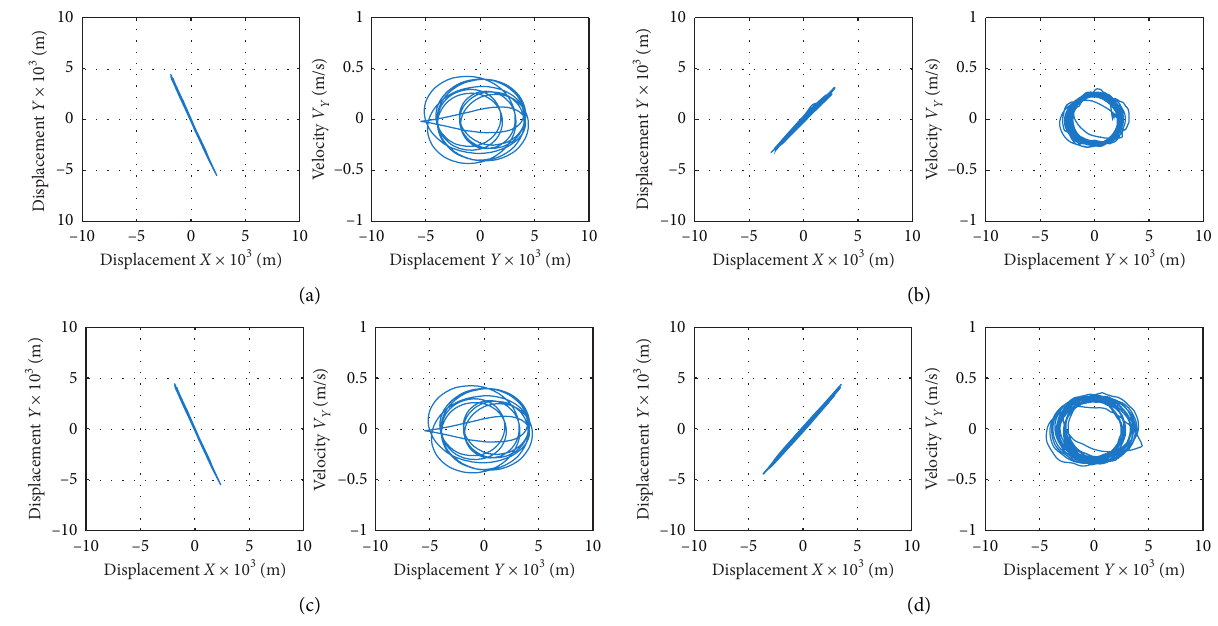
Figure 12: Vibration orbits and phase space plots on springs: upper left (a) and right (b); down left (c); and right (d). Table 2: The diagnostic parameters of measured